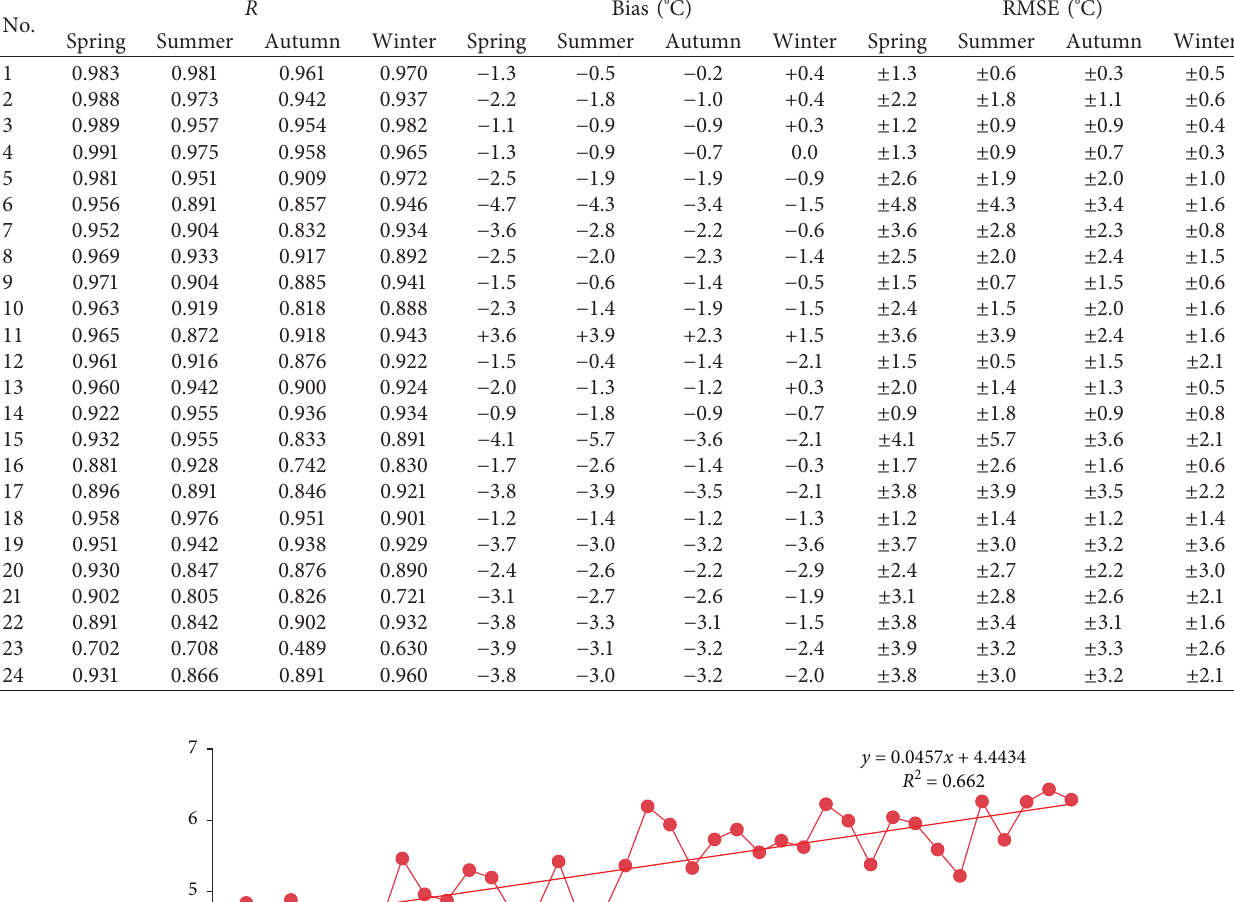
Table 3: Comparison of ERA-Interim seasonal mean temperature with observations at all 24 stations.